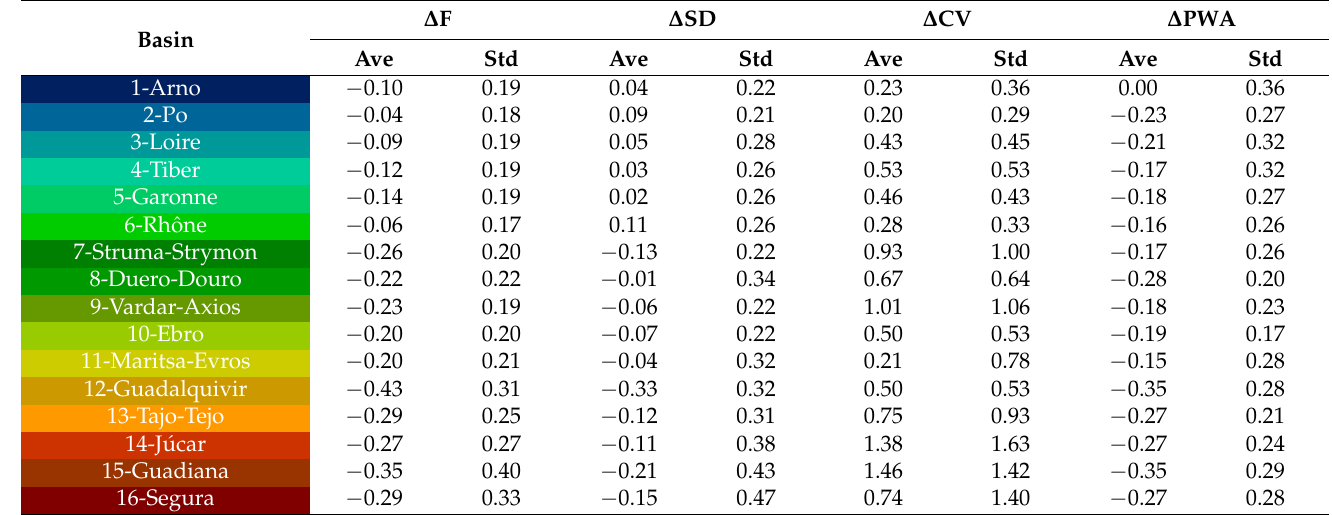
Table 2. Summary of the results of the analysis of changes in streamflow ∆ F, ∆ SD and ∆ CV and Potential Water Availability, ∆ PWA, in the basins analyzed in this study (Ave: average of values for the 35 projections; Std: standard deviation of the values for the 35